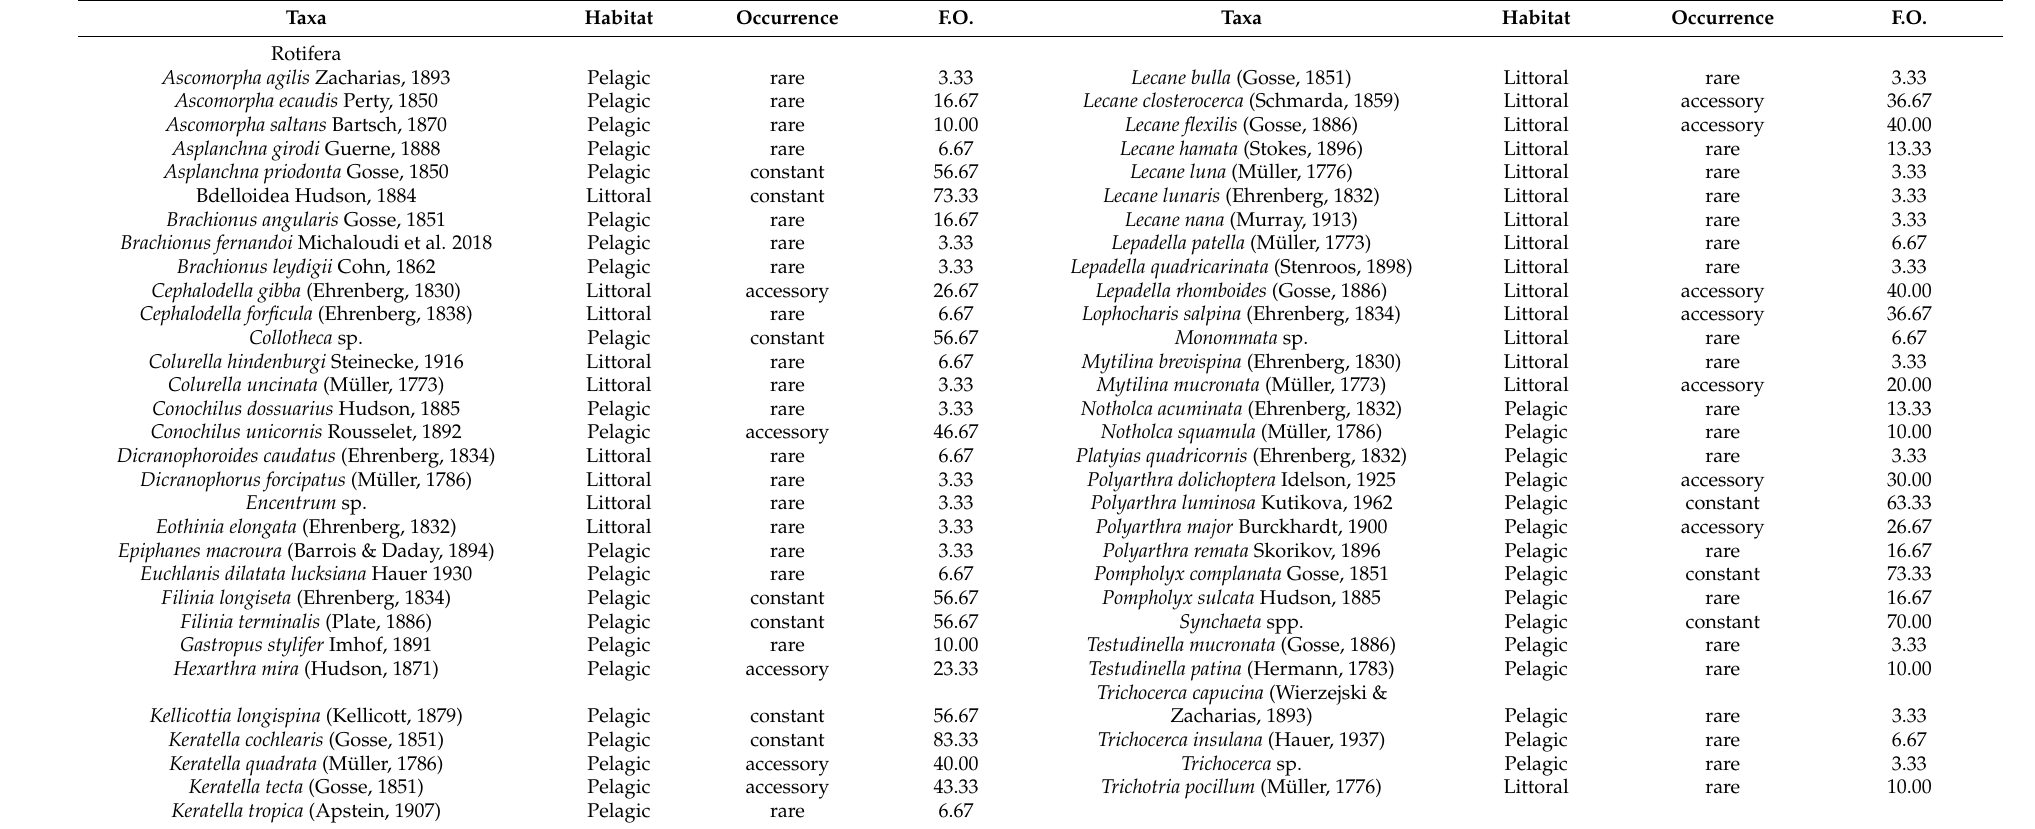
Table 1. List of zooplankton taxa recorded in the Moglicë Reservoir and their occurrence based on frequency of occurrence